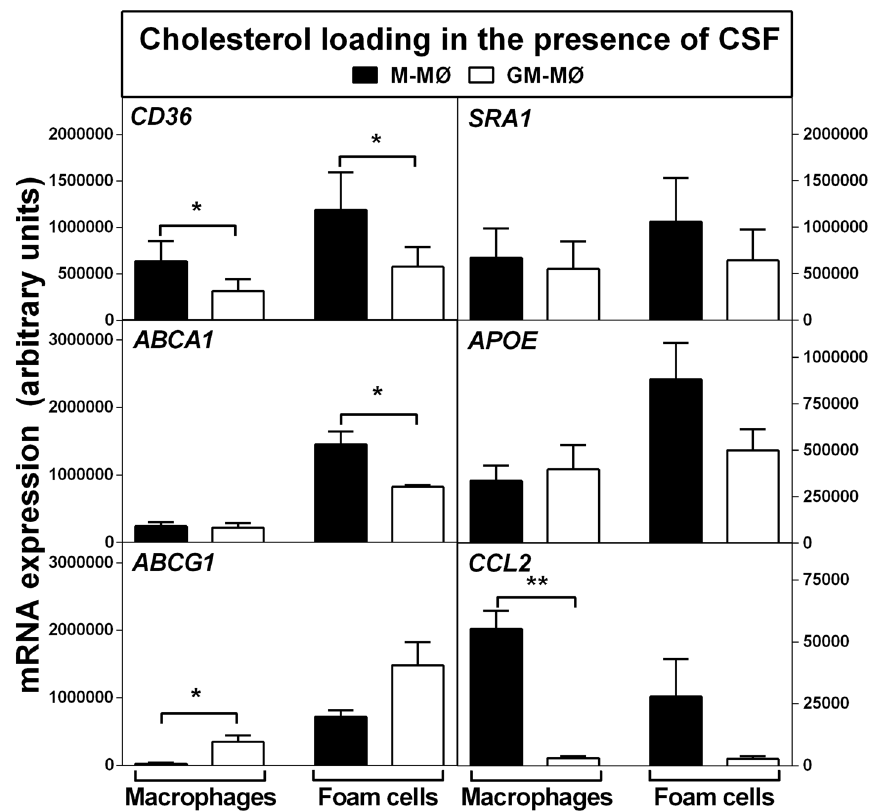
Figure 2. Expression of genes responsible for cholesterol accumulation and inflammation in M-CSF or GM-CSF-polarized macrophages before and after their conversion into foam cells in the presence of CSF. Gene expression levels were determined by quantitative RT-PCR in M-MØ and GM-MØ before (Macrophages) and after (Foam cells) cholesterol loading with acetyl-LDL (25 µg/mL) in the presence of the respective CSF. Data are presented as means ± SEM of 5 individual blood donors and triplicate incubations for each studied gene. *p < 0.05 and **p < 0.01 denote statistically significant differences between the expression levels in M-MØ and GM-MØ, both before and after cholesterol loading, by Wilcoxon Signed-Rank test for paired